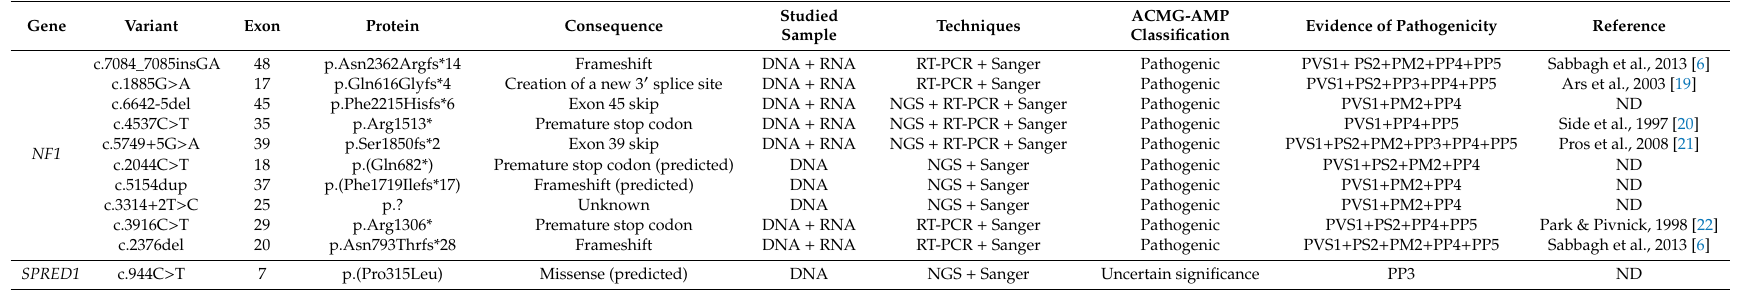
Table 2. Variants features and classification according to the ACMG-AMP